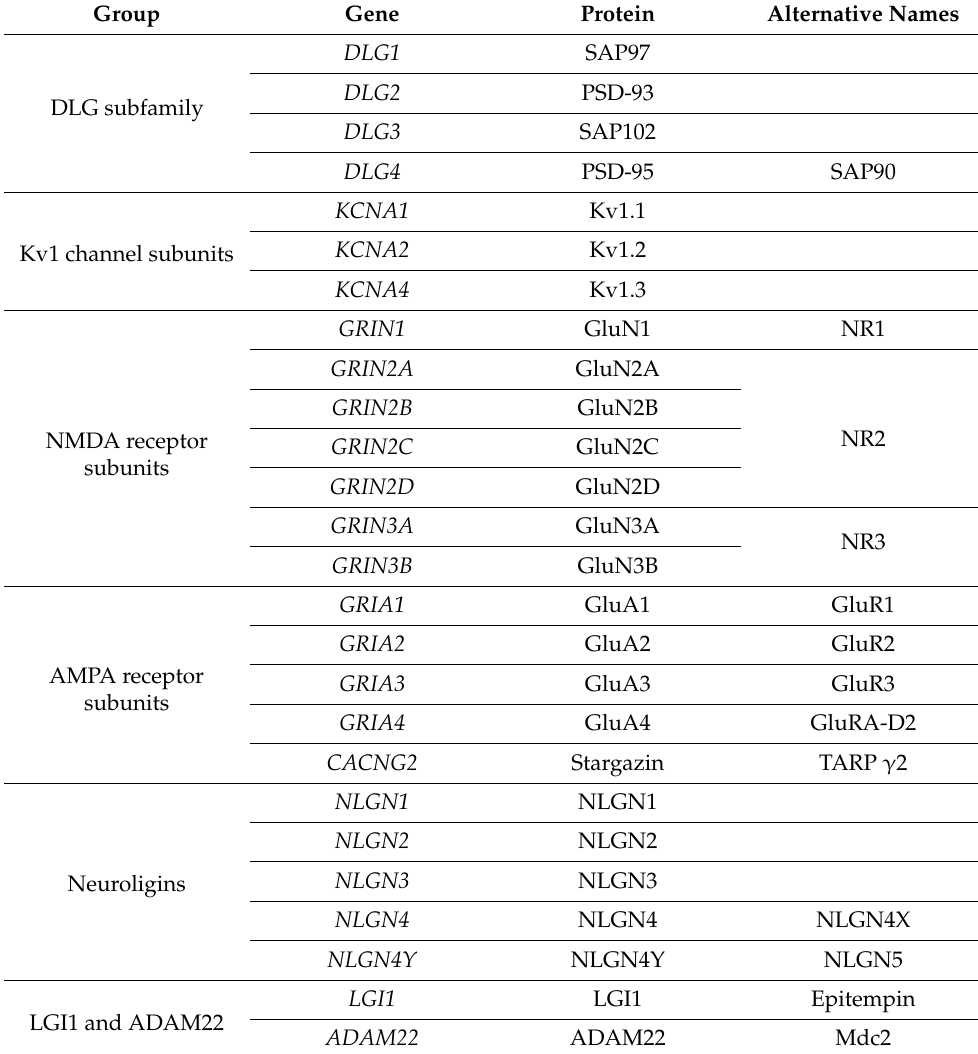
Table 1. List of genes and proteins reviewed in this study. Group Gene Protein Alternative